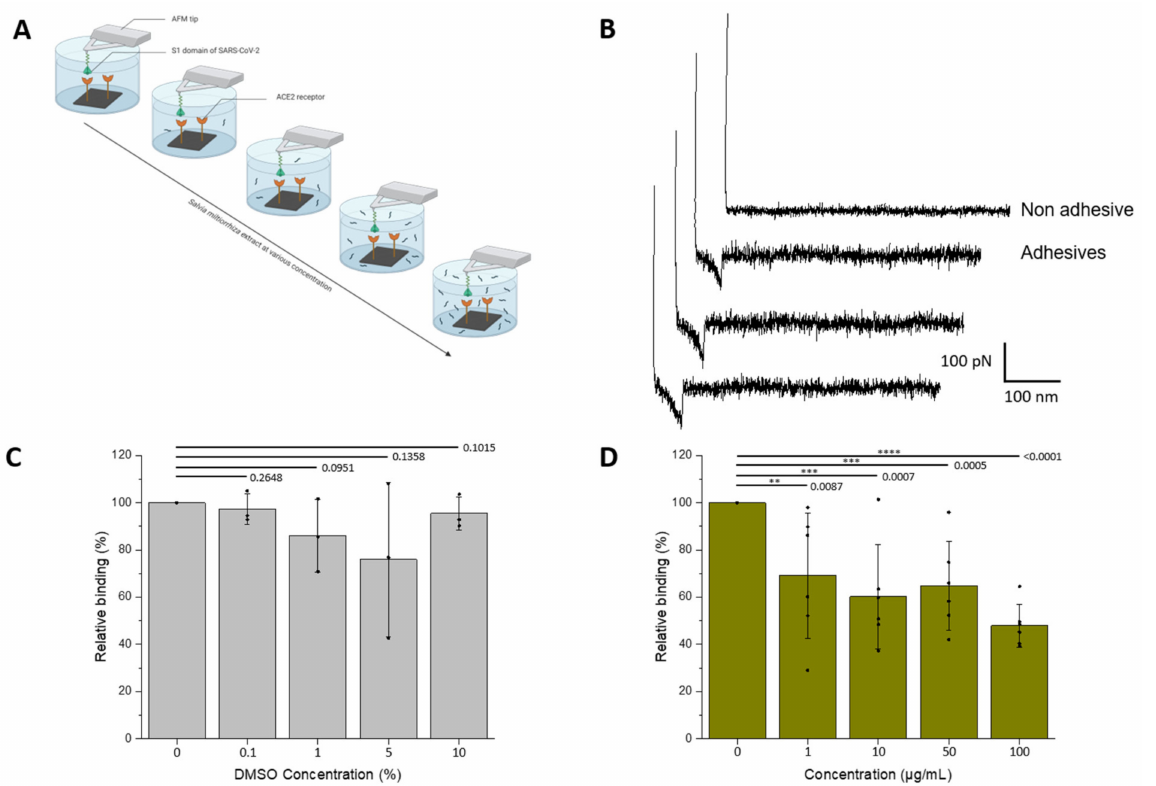
Figure 1. Assessment by AFM of the inhibitory effect of S.miltiorrizha extract on the interaction between the S1-subunit and ACE2. ( A ) The inhibitory potential of roots S. miltiorrhiza extract is assessed by measuring the binding probability between the S1 subunit immobilized on the AFM tip and the ACE2 receptor grafted on a model surface, before and after incubation with the extracts at increasing concentrations (0, 1, 10, 50, and 100 µ M, respectively). ( B ) Examples of non-adhesive (above) and adhesives (below) recorded between S1-functionalized AFM tips and ACE2-coated model surfaces showing specific adhesion events. ( C , D ) Histograms showing the binding probability (BP, expressed in %) as a function of the S. miltiorrhiza extract or DMSO concentration. The error bar indicates s.d. of the mean value. One data point belongs to the BP from one map. The figure on panel a was created with